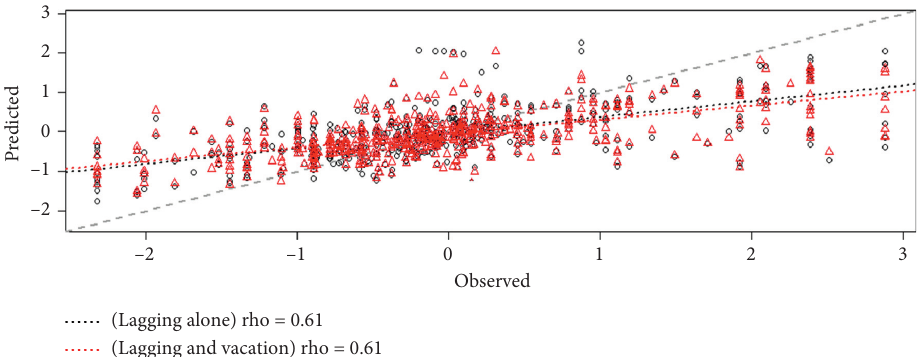
Figure 5: The influence of lagging variables on the evolution of target variable sequences.